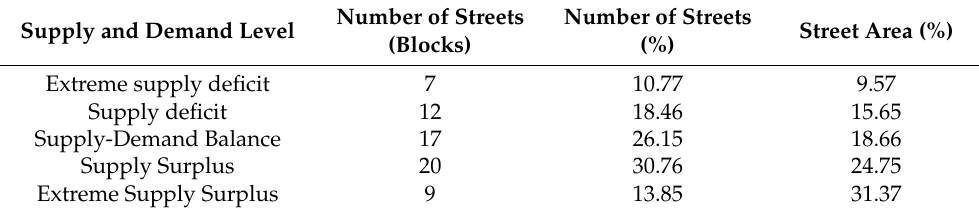
Table 11. Fuzhou city supply and demand balance